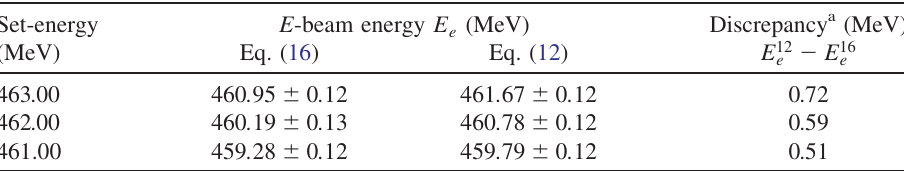
TABLE III. Comparison of the electron beam energy determined by both Eq. (16) and Eq. (12) for a collimation aperture with a radius of 6.35